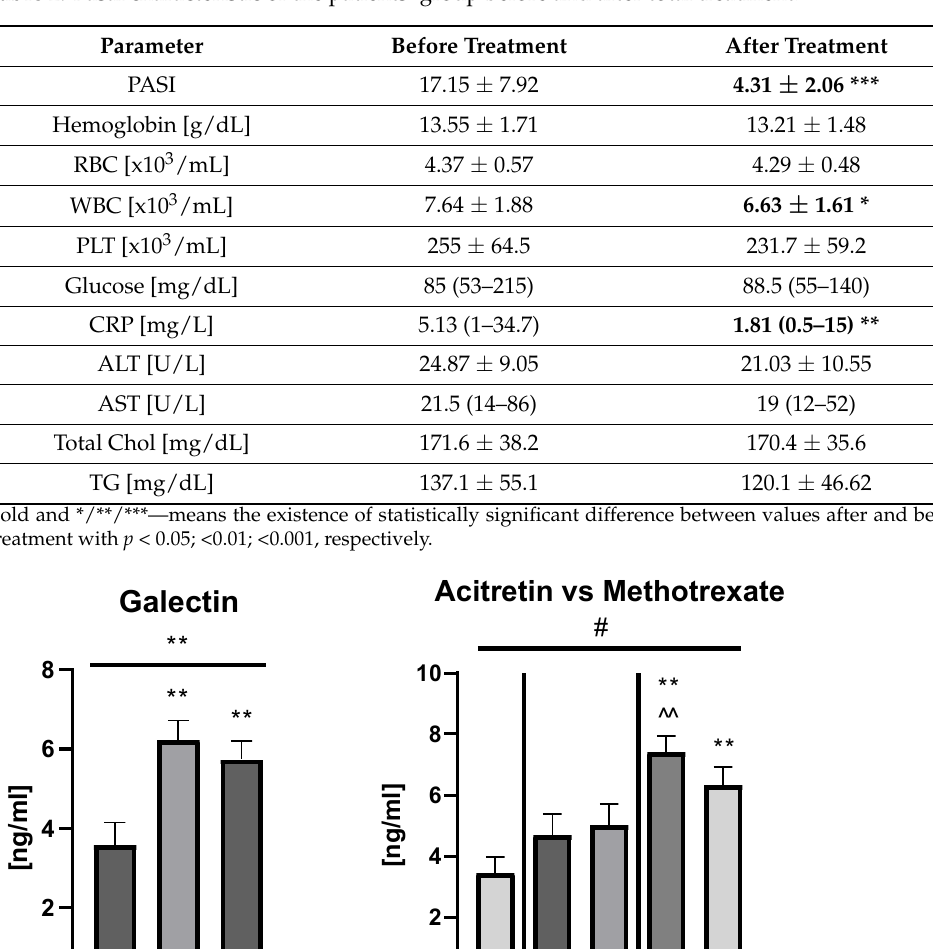
Table 2. Basal characteristic of the patients’ group before and after total treatment.